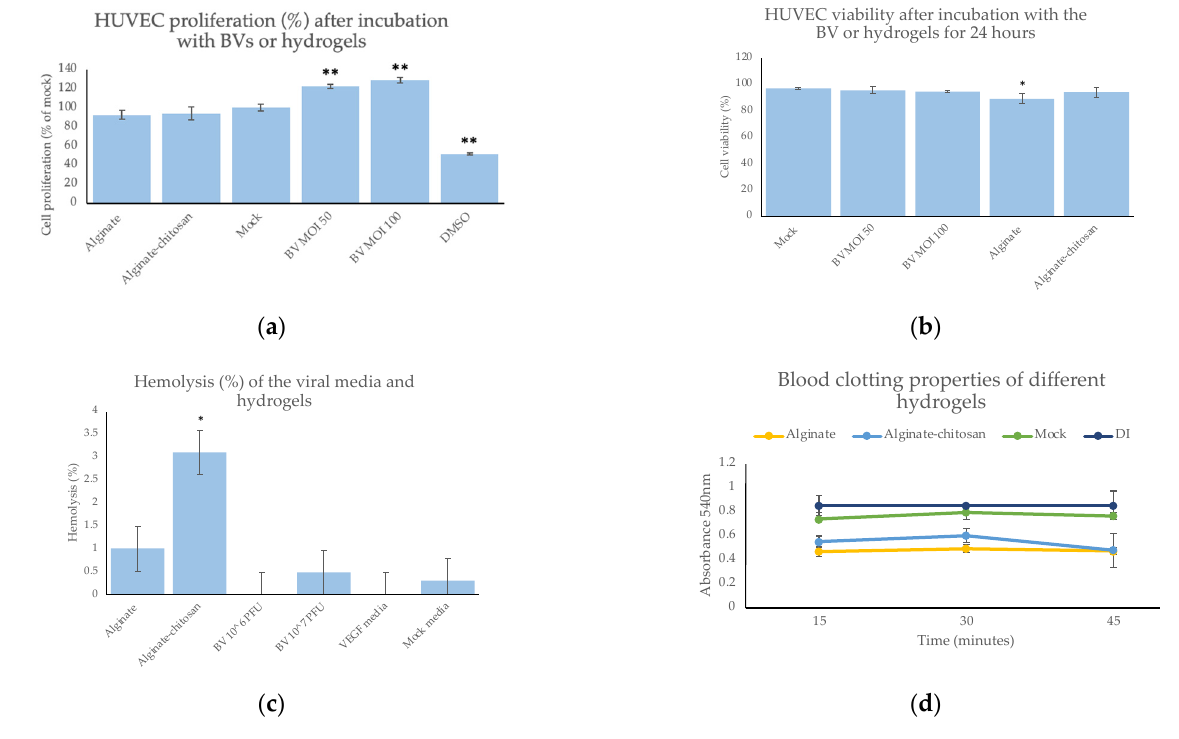
Figure 4. ( a ) MTT proliferation assay with HUVECs after treatment with different hydrogels or the BV compared to the mock transduced cells. ( b ) HUVEC viability (%) after BV transduction or hydrogel incubation for 24 h compared to the mock cells. ( c ) Compared to the mock cell media, hemolysis (%) of the hydrogels, baculovirus (BV), and VEGFA expressed from the BV. ( d ) Whole blood clotting on the surface of the hydrogels compared to polystyrene (mock) and deionized water (control). n = 3 per group and repeated twice. * indicates p < 0.05 and ** indicates p < 0.005.